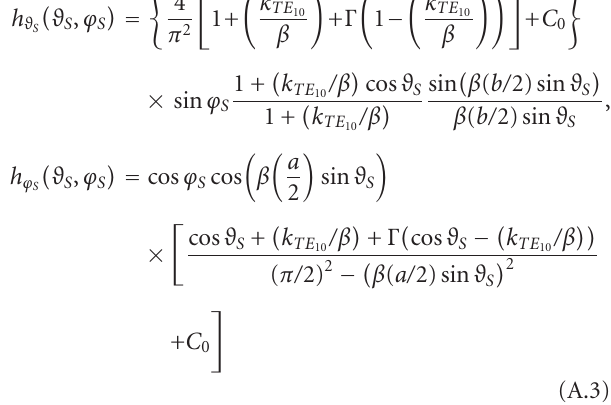
Figure 20: Dual horn, horizontal polarization, di ff erence pattern. Amplitude of the ϕ component of the far